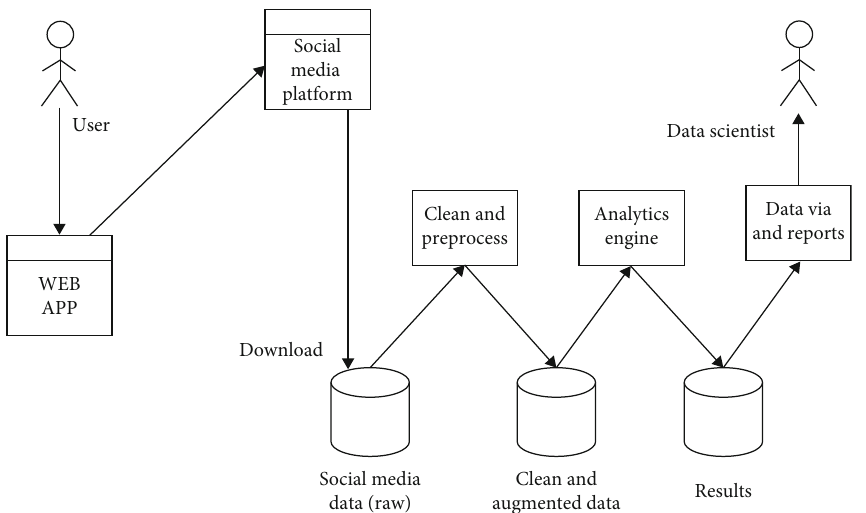
Figure 1: An illustration of social media platform for enhancing the education of college